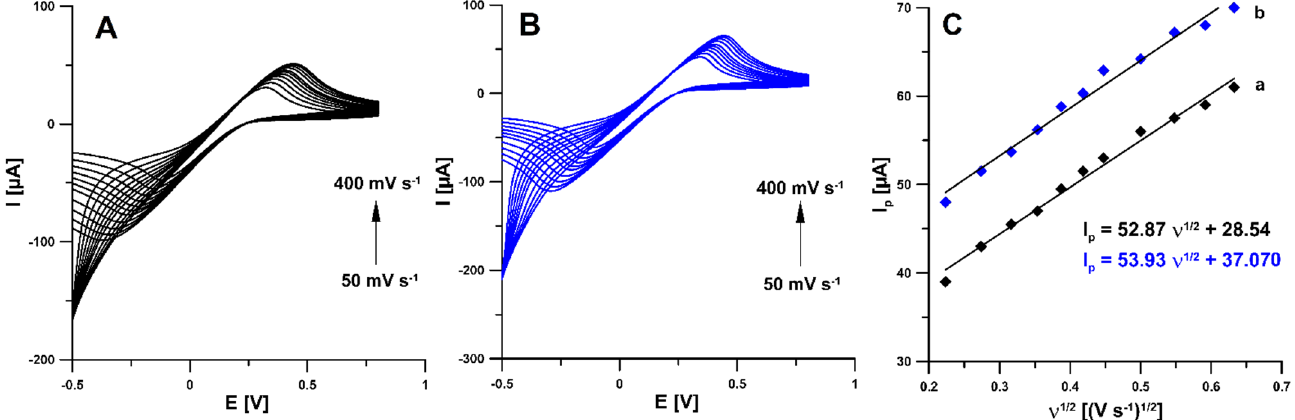
Figure 2. Cyclic voltammograms recorded in a solution of 0.1 M KCl containing 5.0 mM K 3 [Fe(CN) 6 ] at the bare SPBDDE ( A ) and electrochemically activated in 0.1 M NaOH SPBDDE ( B ). ( C ) Dependence between anodic peak currents and the square root of the scan rates for the bare SPBDDE (a) and aSPBDDE (b), ν range of 50–400 mV s − 1 .